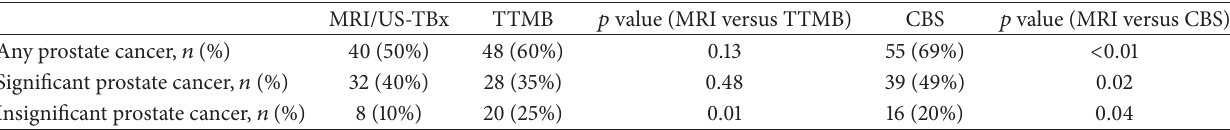
Table 4: Detection rates for significant and insignificant prostate cancer of MRI/ultrasound fusion targeted biopsy versus transperineal template saturation mapping biopsy ( 𝑛 = 80 ).